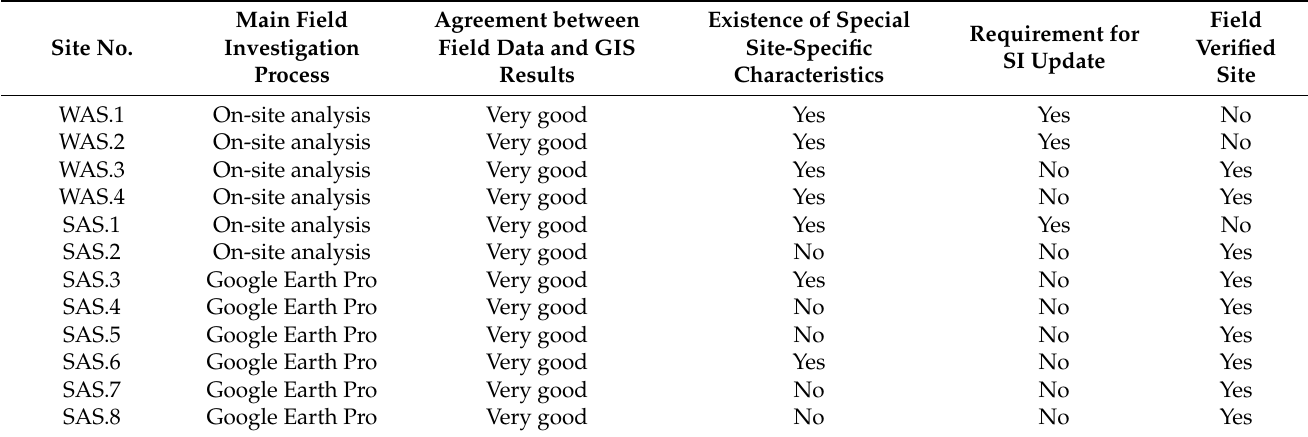
Table 8. Field investigation